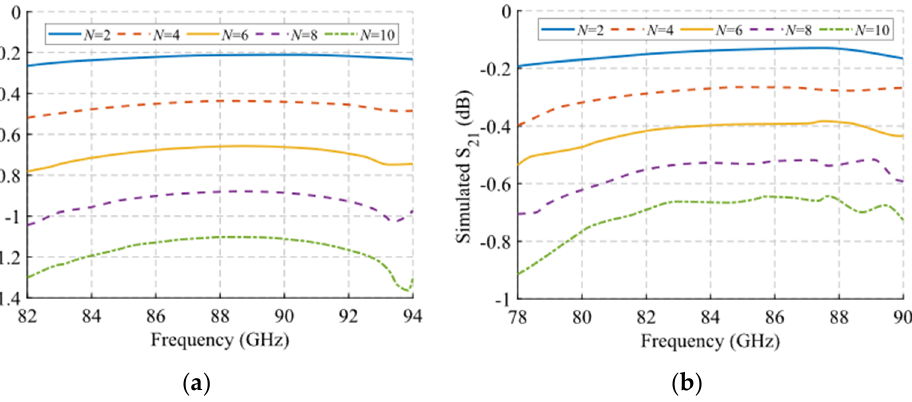
Figure 27. Variation of the S 21 parameter as a function of the number N of unit cells in the filter in glide-symmetric configuration. Filters with ( a ) double-periodic and ( b ) single-periodic unit cells.